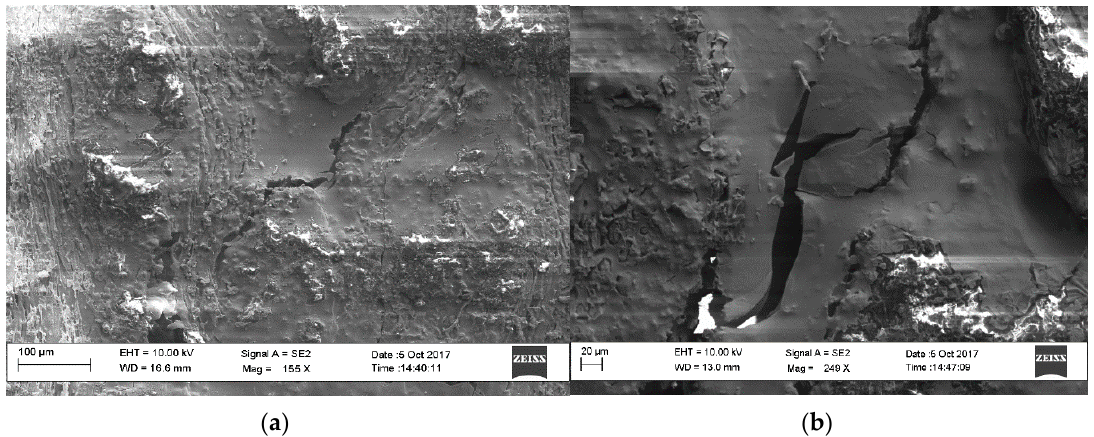
Figure 6. Visualization of matrix cracking. ( a ) global view, ( b ) detailed view.